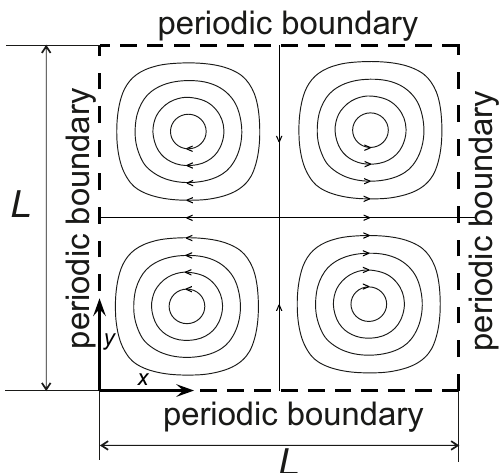
Figure 8. Taylor–Green vortex: Schematic representation of the computational domain and